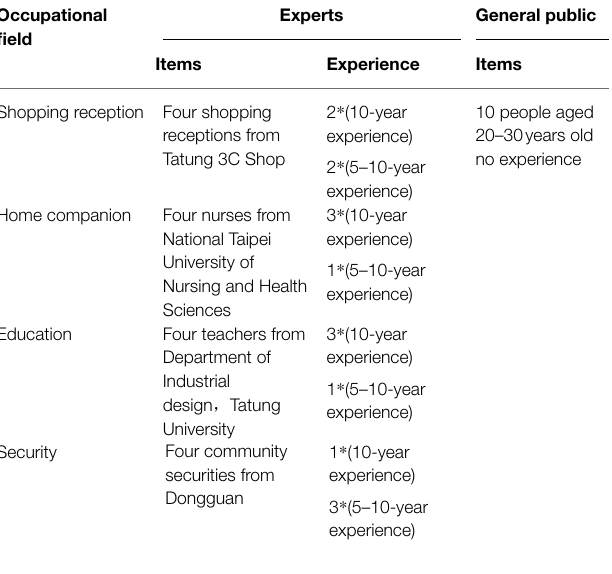
TABLE 1 | Background information of the